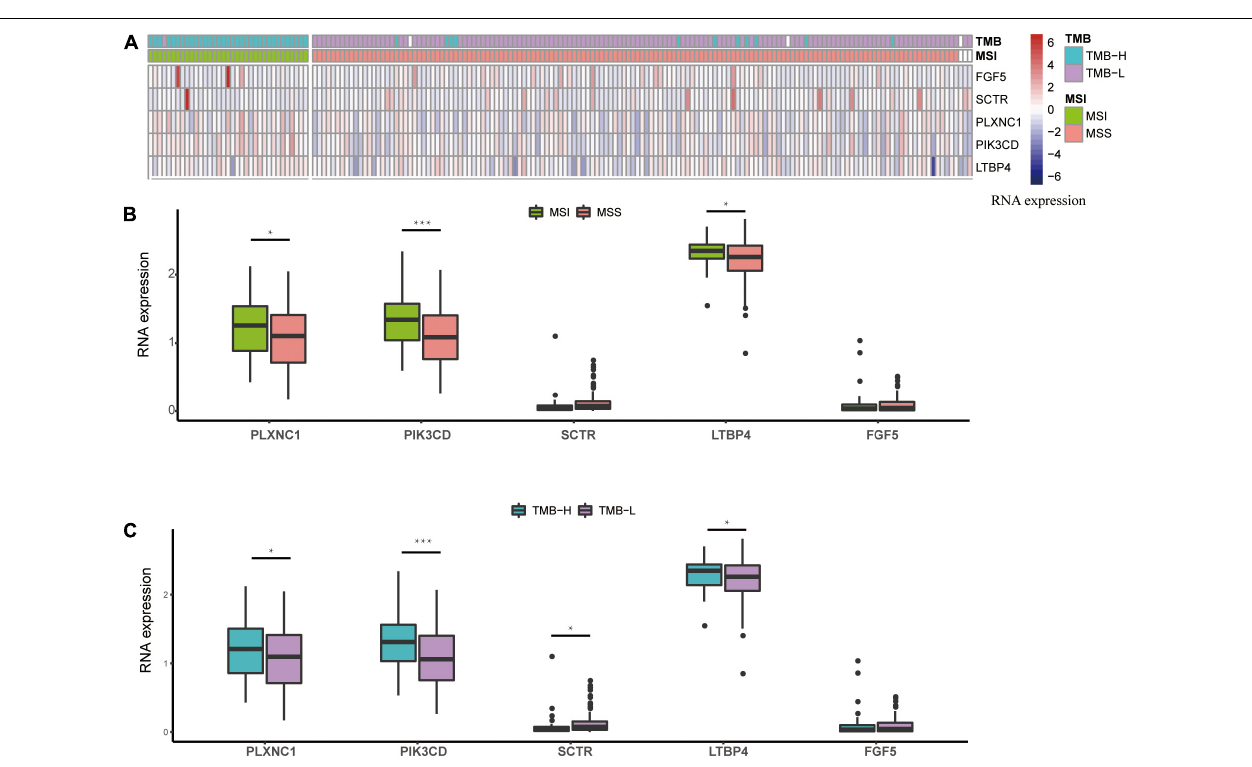
FIGURE 7 | RNA expression profile based on the methylated signature. (A) Heatmap of expression levels, after z-score transformation, for the genes involved in the methylated signature. (B) The boxplot summarizes the mRNA expression levels in MSS and MSI samples. (C) The boxplot summarizes the mRNA expression levels in TMB-H and TMB-L samples. Asterisks indicate genes with significantly ( p < 0.05) different expression as calculated by t -test. MSS: microsatellite stable; MSI: microsatellite instability; TMB-L, low tumor mutational burden; TMB-H, high tumor mutational burden.